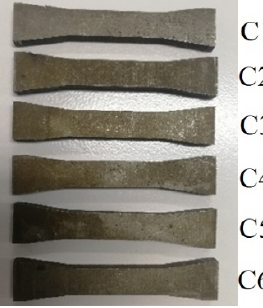
Figure 9. The SLM 316L stainless steel specimens (C1 to C6).